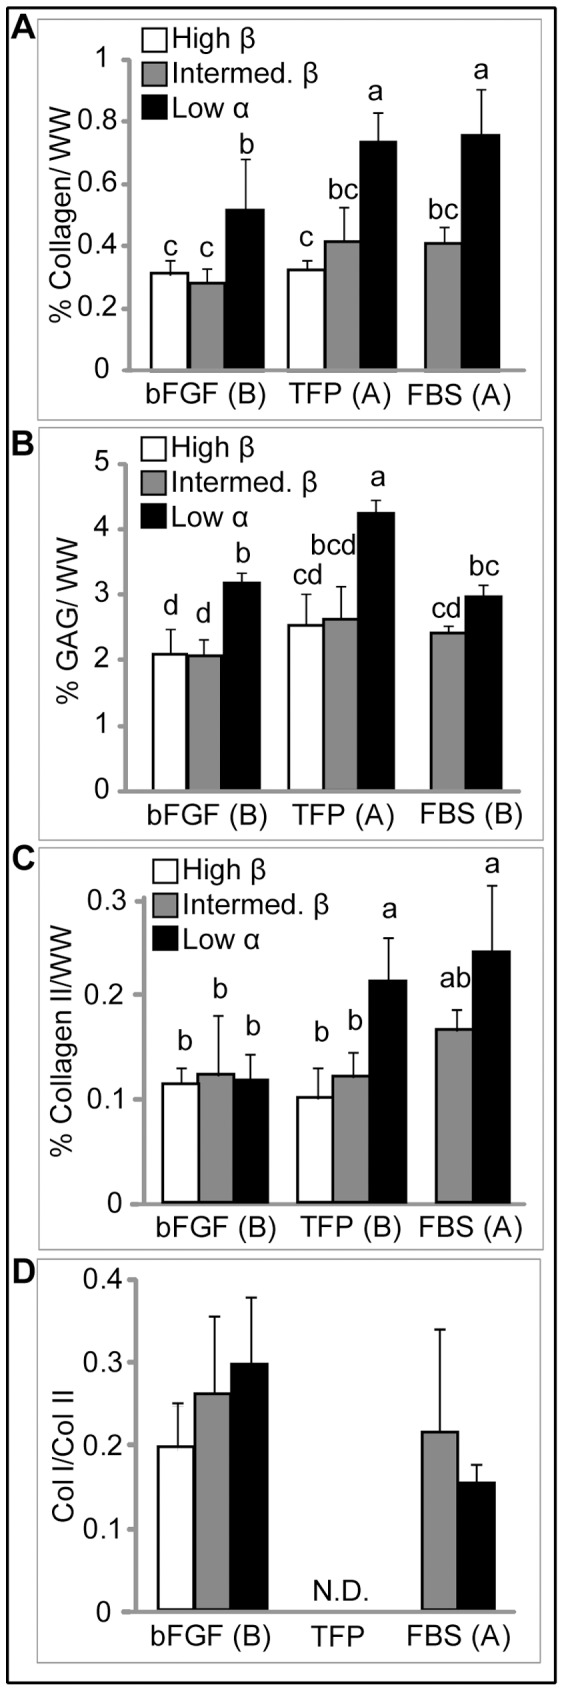
Biochemical Content of Neotissue.Biochemical content was assayed after 4 wks culture. Percent collagen (a), GAG (b), and collagen II (c) are reported per tissue wet weight. Collagen I/II ratio (d) is based on percent per tissue wet weight. Total collagen, GAG, and collagen II were significantly increased in Low density constructs. TFP expansion medium supplementation signficnatly increased GAG content while bFGF supplementation significantly increased the collagen I/II ratio. Type I collagen was below the limit of detection for constructs expanded with TFP supplementation (N.D.: not detected). All data is presented mean ± s.d. Individual factor levels or groups not possessing a common letter are significantly different.